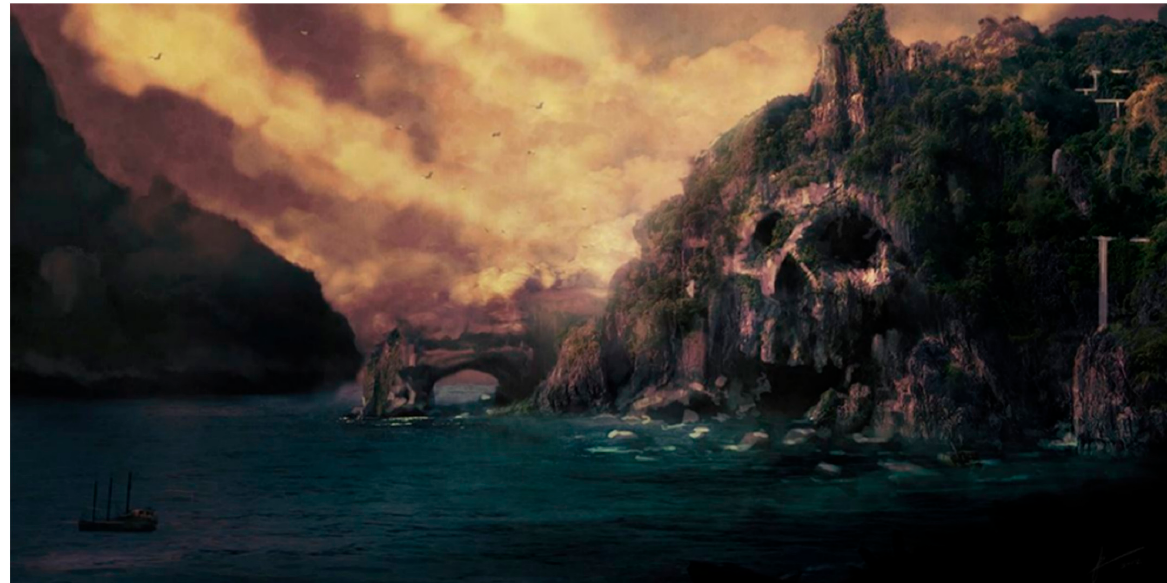
Figure 11. A skull is carved in Kong’s lair (2017). https://www.comicbookmovie.com/sci-fi/kaiju/king_kong/first-official- kong-skull-island-image-teases-the-enormity-of-the-great-ape-a143485#gs.qcbzic (accessed on 1 January 2021).